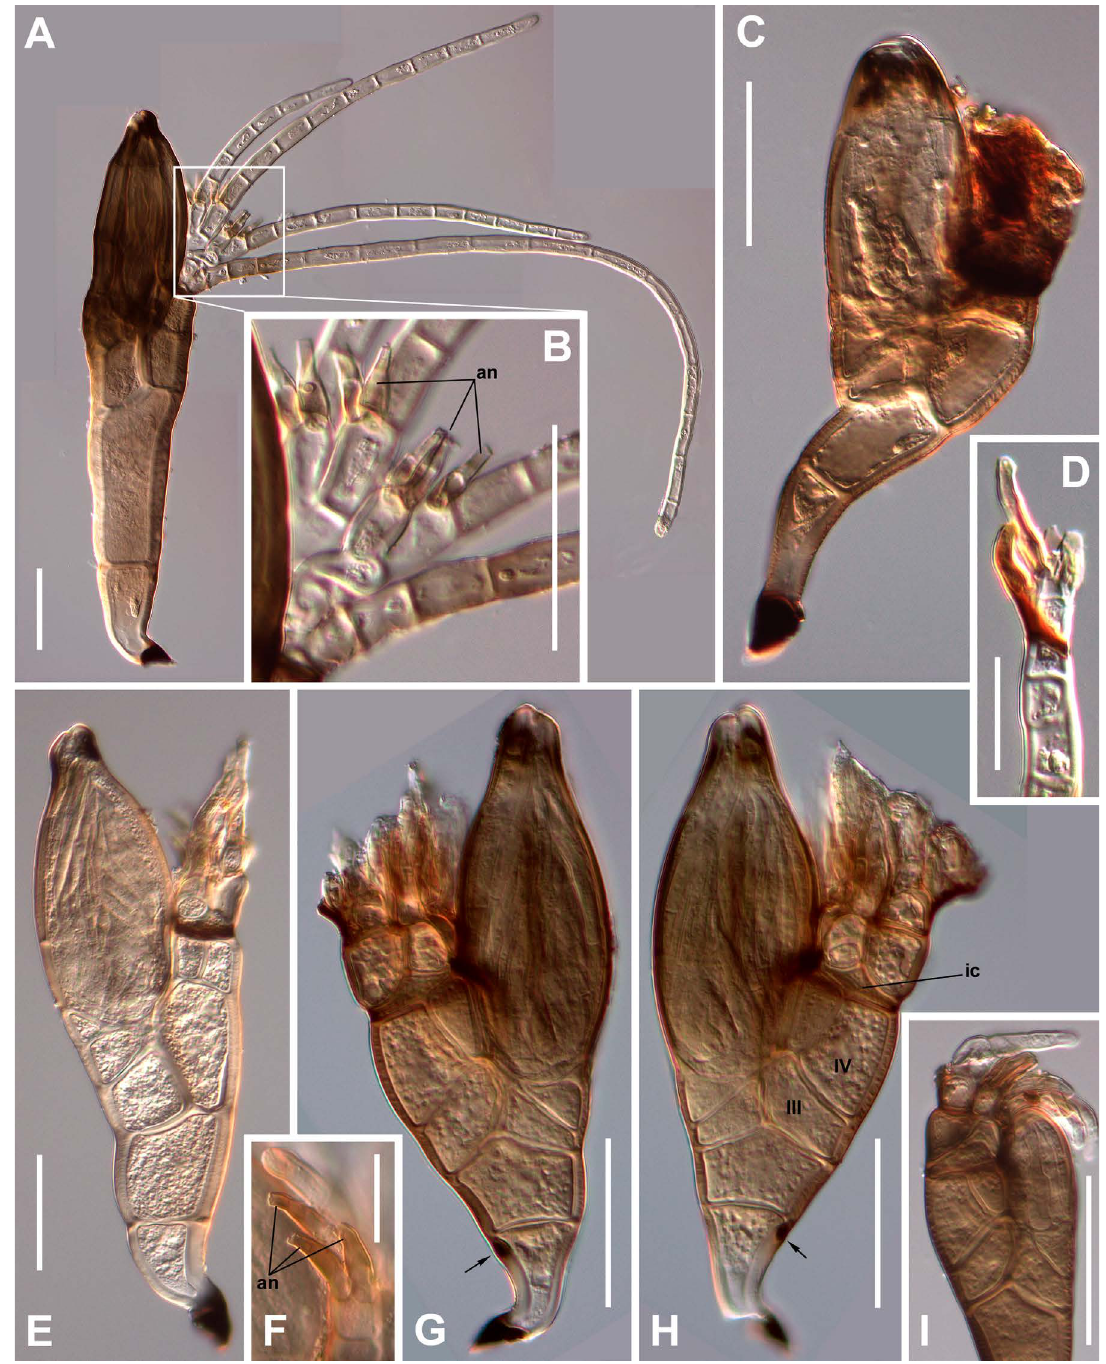
Fig. 36. Laboulbenia spp. A – B . L. leisti J.Siemaszko & Siemaszko. A . Mature thallus with lower area of appendages in detail (B) with labelled antheridia (an). – C – D . L. lichtensteinii F.Picard. C . Mature thallus. D . Upper part of an immature thallus showing the young appendage. – E – F . L. littoralis De Kesel & Haelew. E . Mature thallus. F . Antheridia (an) in detail. – G – I . L. luxurians Peyr. G – H . Mature thalli with labelled cells III, IV, insertion cell (ic), and the black spot on the upper dorsal side of cell I (arrow). I . Appendage from an immature thallus in detail. Scale bars: A–C, E, G–I = 50 µm; D, F = 25 µm. Photographs from slides ZMUC C-F-122760 (A–B), ZMUC C-F-122576 (C–D), ZMUC C-F-123730 (E–F), ZMUC C-F-123642 (G–H), ZMUC C-F-123515